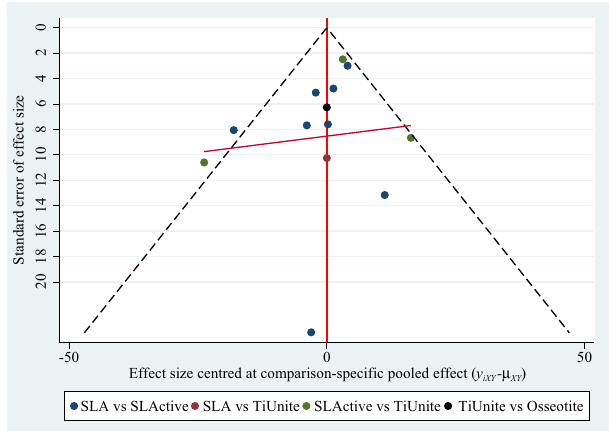
Figure 5. Funnel plot assessing publication bias of the final healing stage of BIC